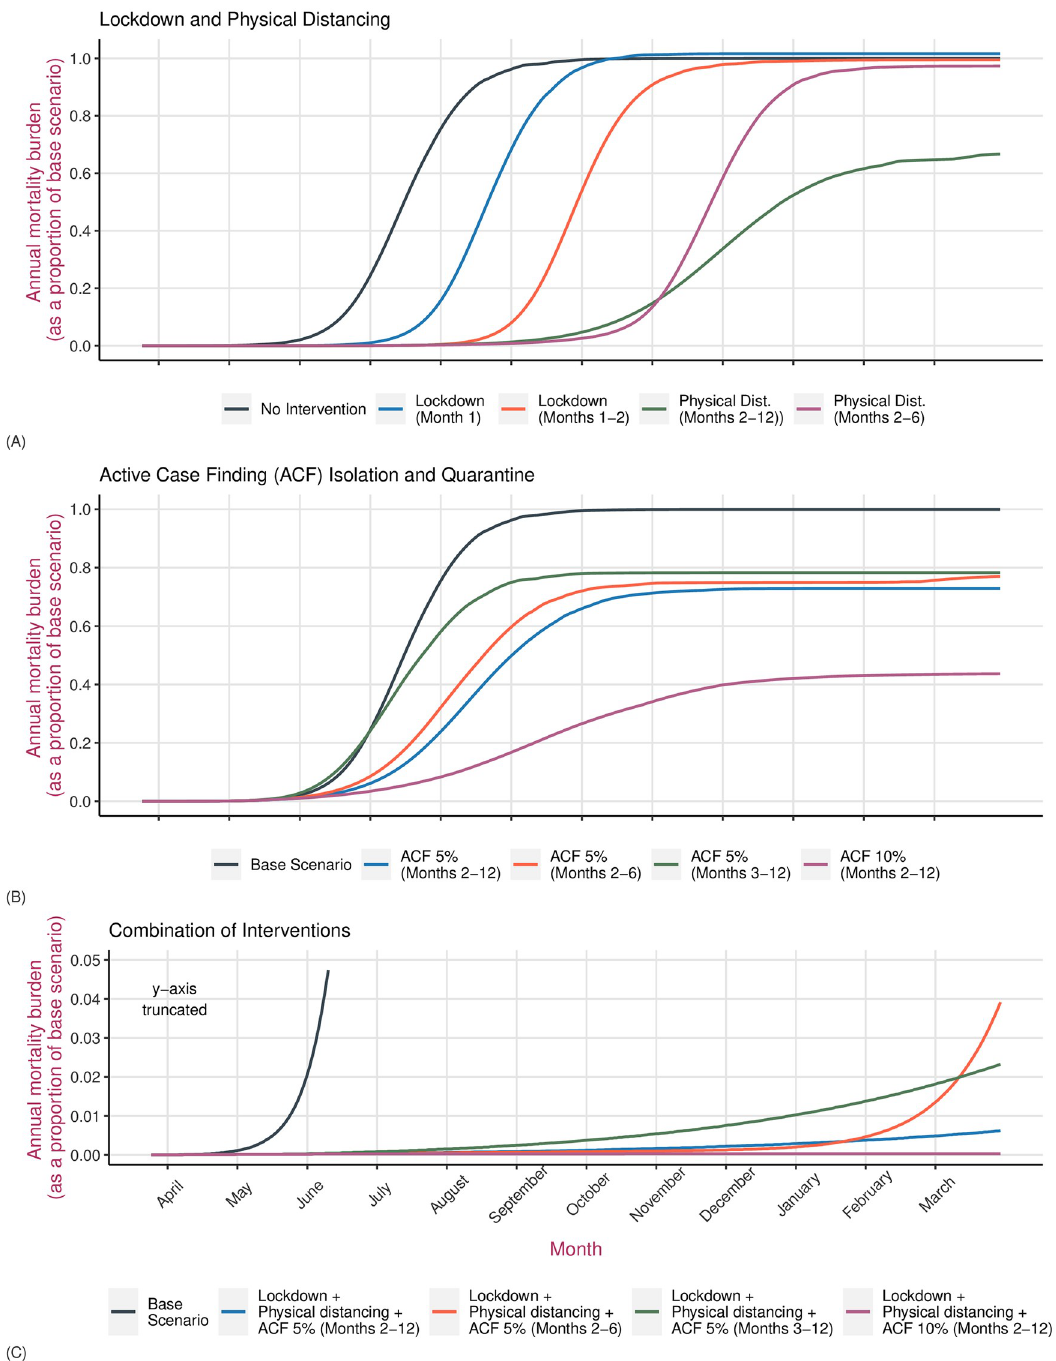
Fig 5. A comparison of the effectiveness of interventions against COVID-19 in reducing mortality burden. Panel (A) on the top compares lockdown or physical distancing measures implemented for a variable duration as compared to the base scenario of no intervention. Panel (B) in the middle compares active case finding measures with the base scenario. Panel (C) at the bottom compares the effectiveness of a combination of interventions with the base scenario of no intervention. The y-axis has been truncated in Panel (C) to accommodate observations that are closer to the